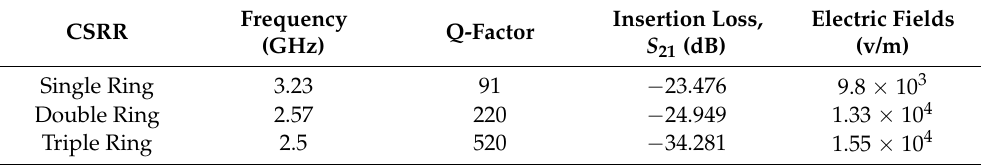
Table 2. The comparison of simulation performance of different rings of CSRR.